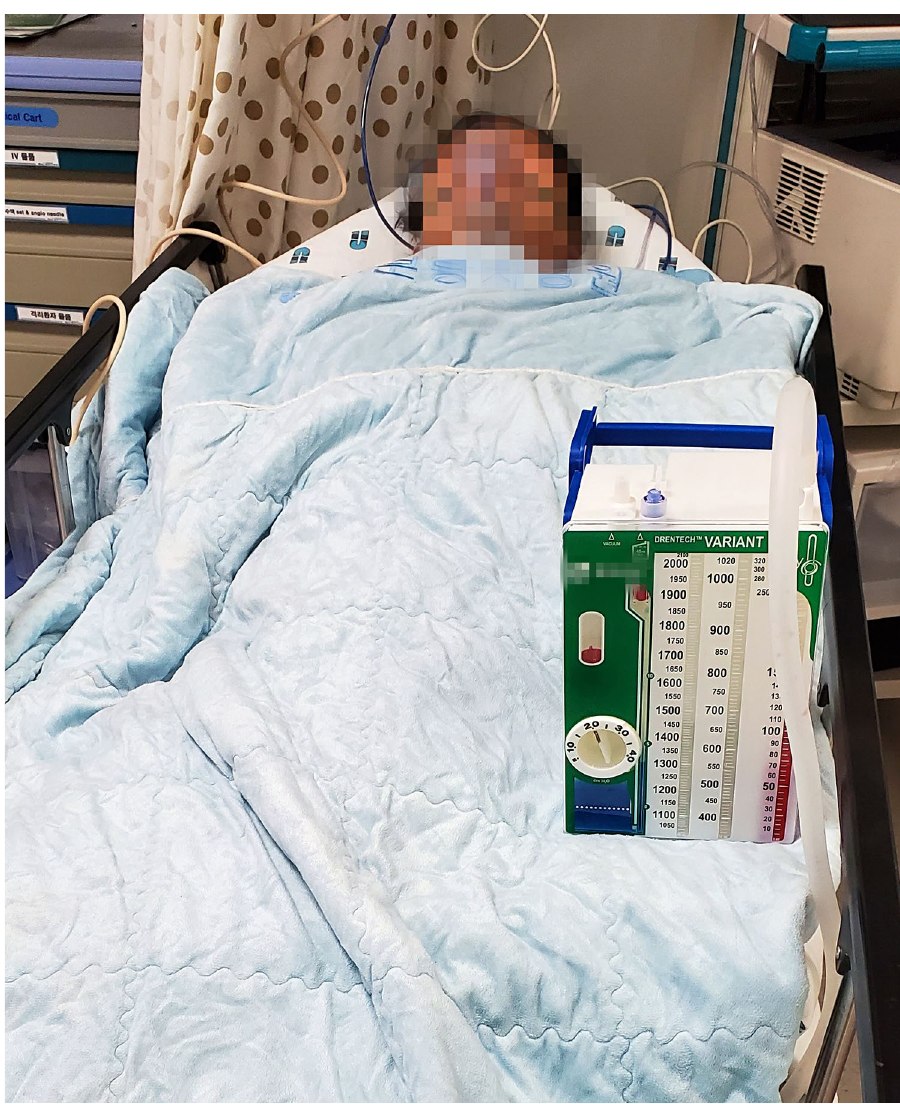
Figure 3. After the operation, the chest tube was lifted approximately 30 cm above the patient for 30 min without clamping in the recovery room.